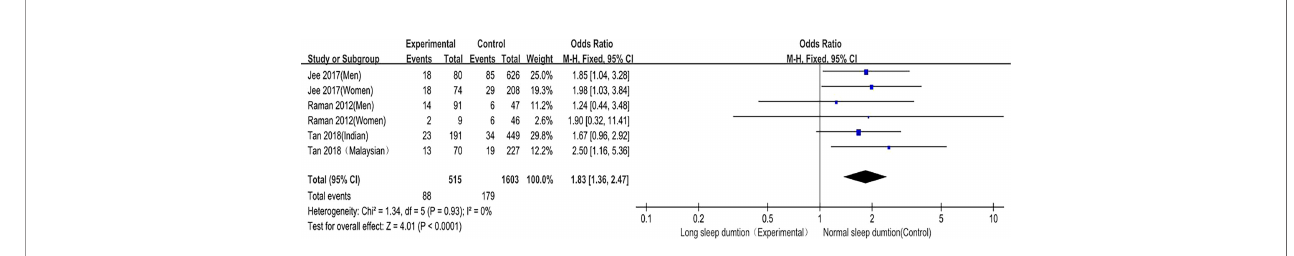
FIGURE 7 | Forest plot of long sleep duration and DR